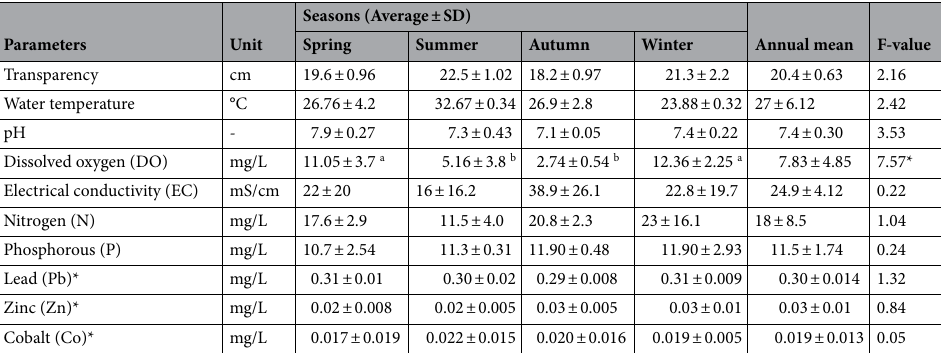
Table 1. Seasonal variation of some physicochemical characteristics and nutrient contents (average ± standard deviation (SD) in water samples collected from drainage water. F-values represent repeated measures ANOVA. *Heavy metals limits in drainage water, according to the Egyptian Law 48/1982, are Pb ≤ 0.5, Zn ≤ 5.0, Co ≤ 2.0 mg/L. *: p ≤ 0.05. Small letters “a” and “b” indicate to significant variation of post-hoc Duncan test.